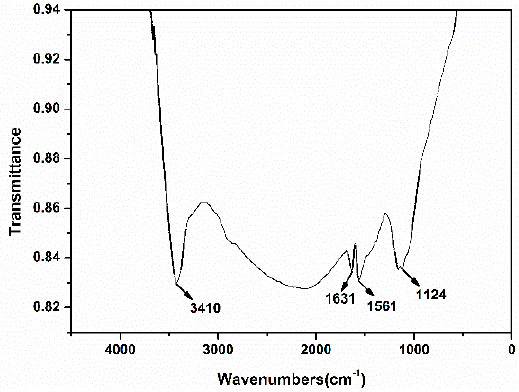
Figure 6. FTIR of self-assembled nano-Fe 3 C@RGO aerogel.